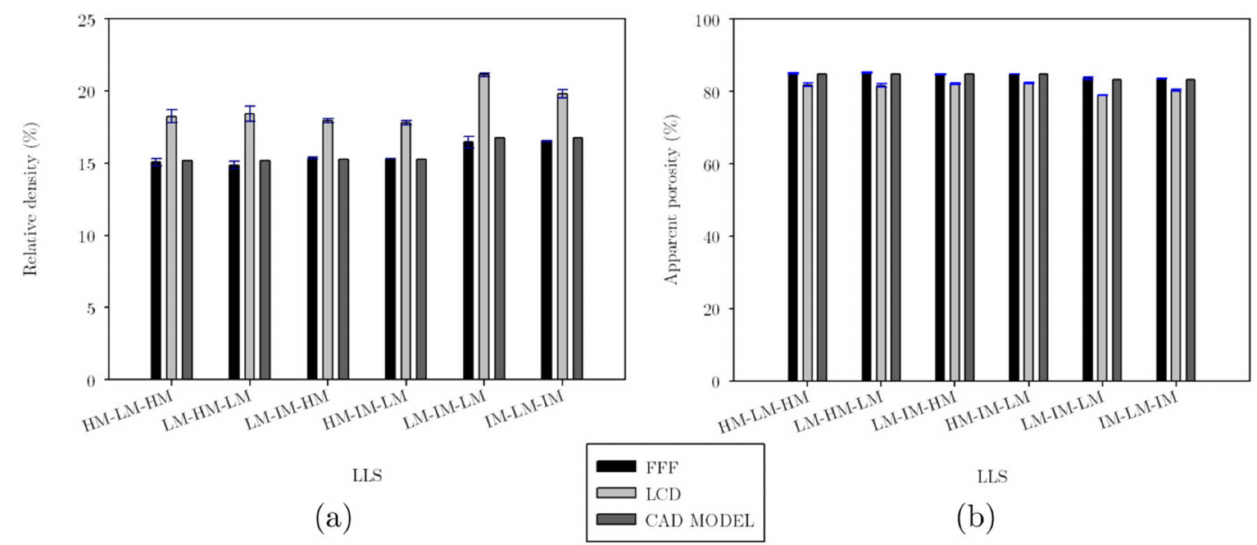
Figure 15. Comparison of the actual relative density ( a ) and the apparent porosity ( b ) of the additively manufactured samples and the computational models for